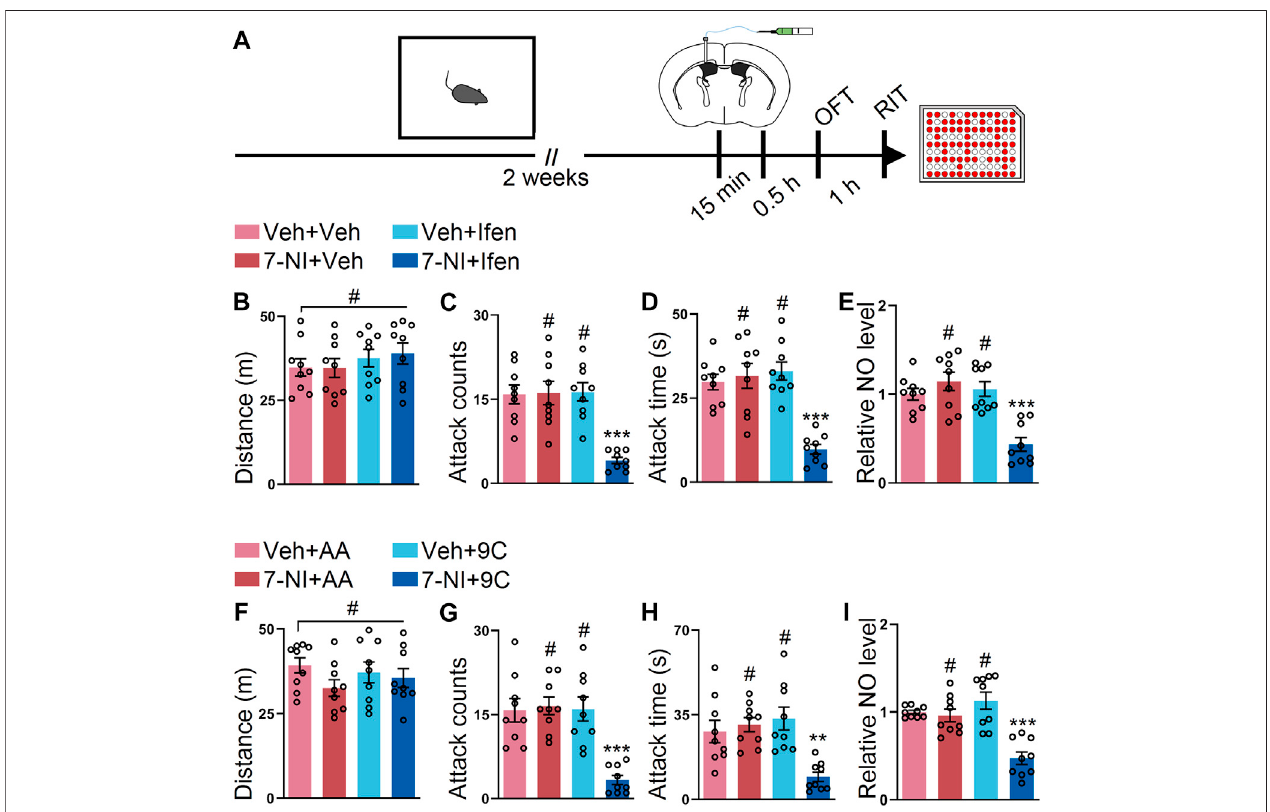
FIGURE 6 | Low dose of 7-NI plus ifenprodil or low dose of 7-NI plus TAT-9C had additive effects on reducing the SI-induced heightened attack behavior. (A) An outlineoftheexperimentalprocedureforbehavioraltestsandNOdetection.Themicewereimplanted withaguidecannulaandsinglyhousedfor2 weeks.Afterward,7- NI and ifenprodil or 7-NI and TAT peptide were injected via the ICV route, and behavioral tests were performed. (B) Total distance of the mice that received 7-NI, ifenprodil,orbothduringtheOFT(F 3,32 (cid:1) 0.5849, p (cid:1) 0.6293). (C) Attackcountsofthemicethatreceived7-NI,ifenprodil,orbothduringtheRIT(F 3,32 (cid:1) 14.16, p < 0.001). (D) Attackdurationofthemicethatreceived7-NI,ifenprodil,orbothduringtheRIT(F 3,32 (cid:1) 16.82, p < 0.001). (E) TherelativeNOlevelofthecortexfromthemice thatreceived7-NI,ifenprodil,orboth(F 3,32 (cid:1) 14.97, p < 0.001). (F) Totaldistanceofthemicethatreceived7-NI,TATpeptide,orbothduringtheOFT(F 3,32 (cid:1) 1.133, p (cid:1) 0.3503). (G) Attack countsofthe mice thatreceived 7-NI, TATpeptide,or both during theRIT(F 3,32 (cid:1) 13.52, p < 0.001). (H) Attack duration ofthemice thatreceived7- NI, TAT peptide, or both during the RIT (F 3, 32 (cid:1) 8.508, p < 0.001). (I) The relative NO level of the cortex from the mice that received 7-NI, TAT peptide, or both (F 3, 32 (cid:1) 16.27, p < 0.001). Data are represented as mean ± SEM. * p < 0.05, ** p < 0.01, *** p < 0.001, and # indicates not signi fi cant.